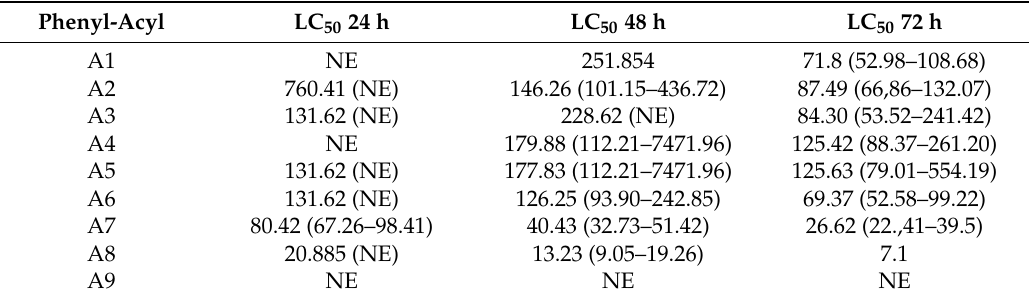
Figure 7. The toxicity of phenyl-acyl compounds and copper sulfate on Daphnia pulex De Geer neonates. Control = the culture medium without a compound. Table 1. LC 50 values for D. pulex De Geer neonates exposed to different phenyl-acyl compounds at 24, 48, and 72 h. The confidence intervals (95%) are given in parenthesis.